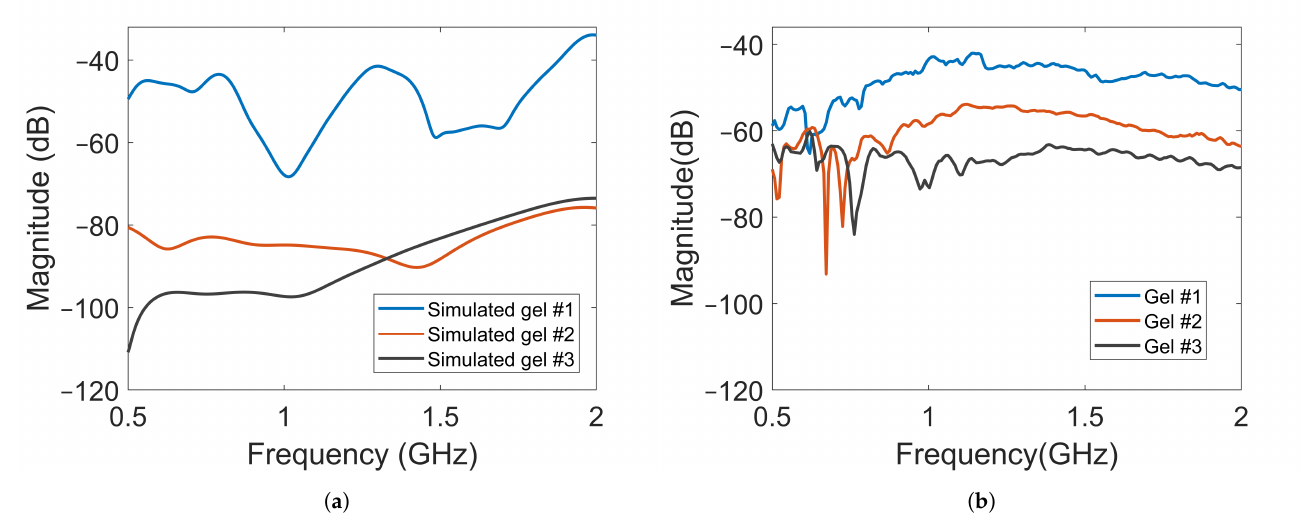
Figure 10. Magnitude of transmission coefficients between the transmitting antenna and Probe A for Gel #1, Gel #2 and Gel #3: ( a ) simulated transmission coefficients; ( b ) measured transmission